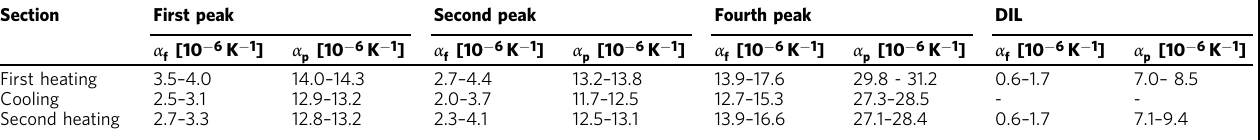
Fig. 2 with arrows. In all curves, one can identify the dilatometric increases by about 12 K. The QMo alloy has a higher dilatometric transition temperature and glass transition temperature. The transition temperature at 507 K in the as-cast state and increases QNb alloy has a dilatometric transition temperature of approxi- to 542 K in the cooling and second heating section. It is mately 458 K in the as-cast state. After relaxing the structure by interesting to note that the CTEs derived from the fourth peak for heating close to T the dilatometric transition temperature both alloys are signi fi cantly higher than those derived from the fi rst g